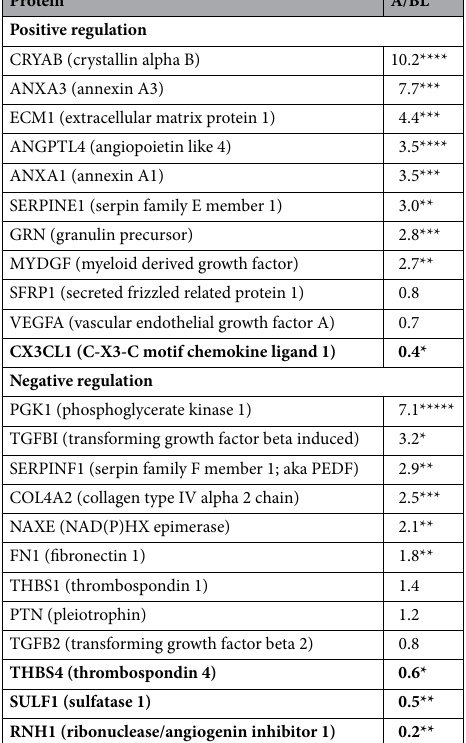
Table 3. RPE directional secretion of angiogenic factors. A/BL = apical to basolateral ratio; proteins are listed from highest to lowest A/BL within each category. Bold highlights proteins with more basolateral than apical secretion. P-values were calculated with a two-tailed student’s T-test with a Benjamin-Hochberg adjustment. P-value < 0.05 (*), < 0.01 (**), < 0.001 (***), < 0.0001 (****), or > 0.05 (non-significant, no asterisk).